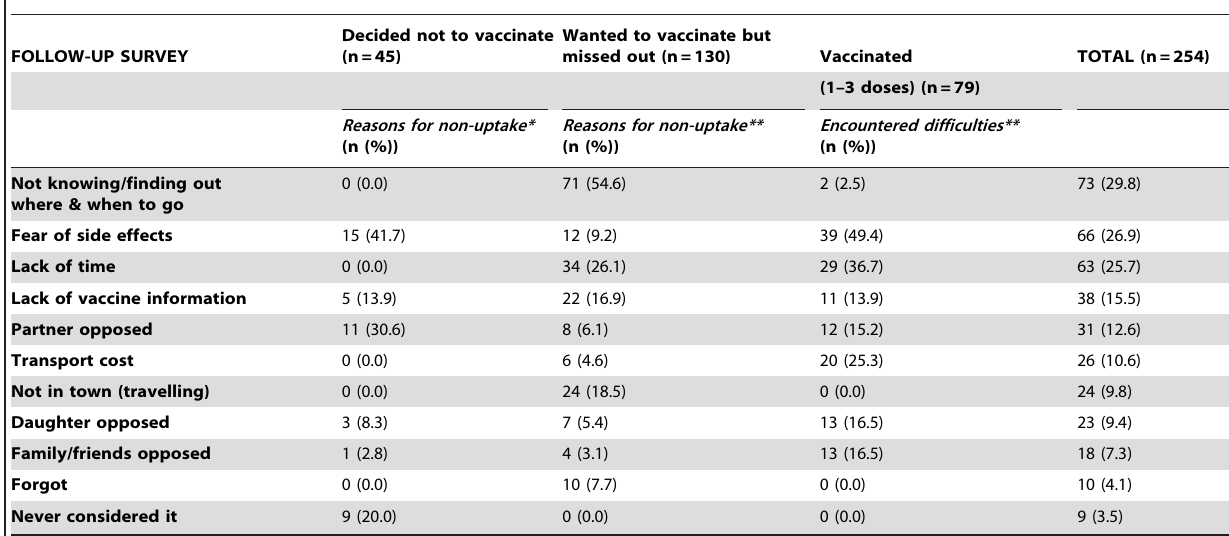
Table 5. Encountered difficulties and reasons for non-uptake of the HPV vaccine.